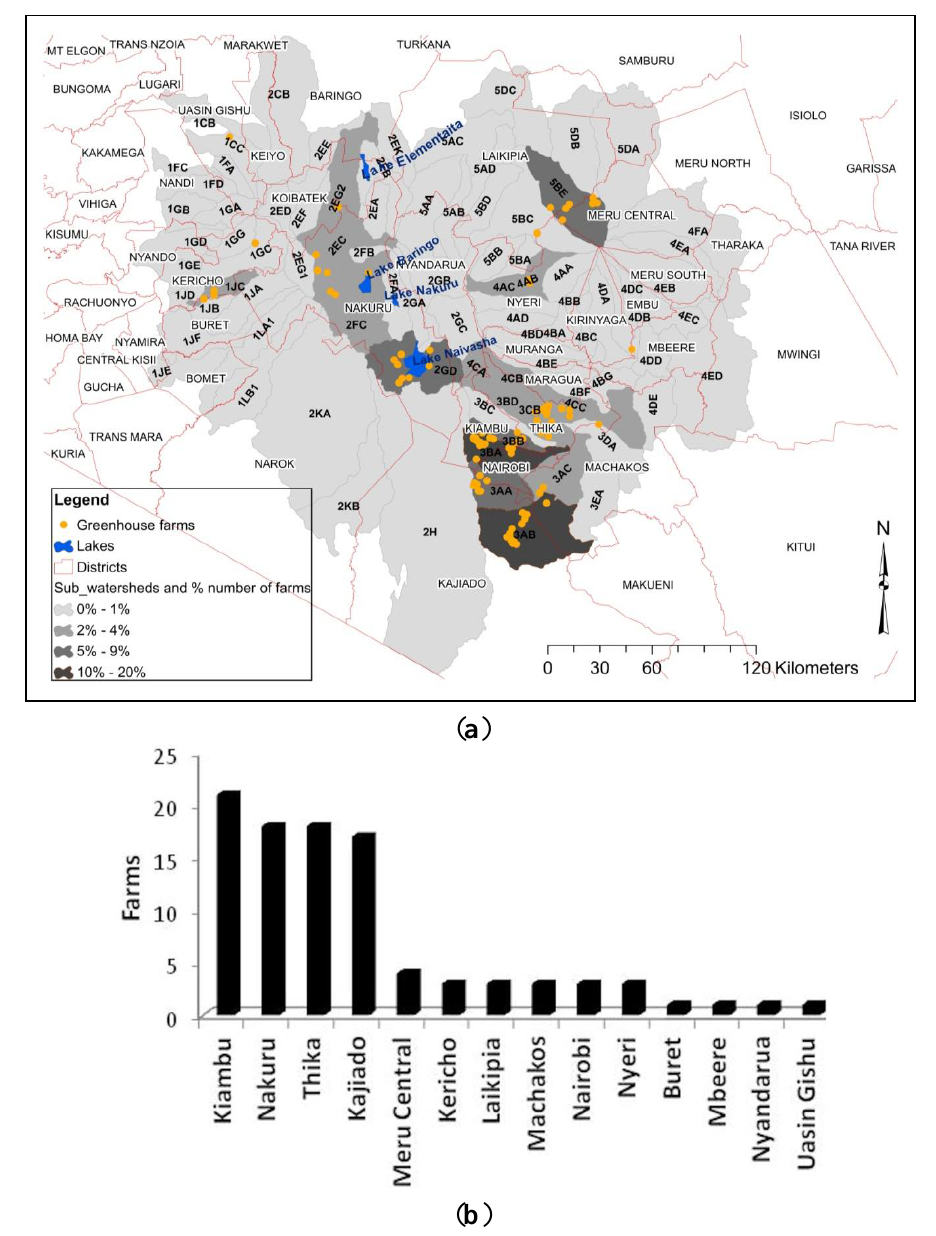
Figure 2. ( a ) Spatial distribution of greenhouse commercial horticulture in the central highlands of Kenya within sub-watersheds in 2000–2011; ( b ) Within